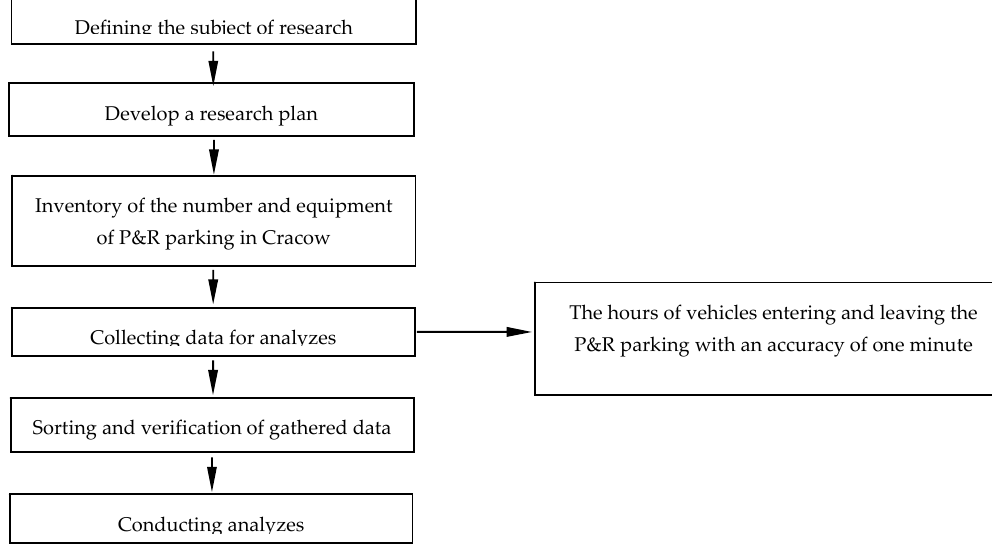
Figure 6. The research algorithm for the analysis of the use of P&R parking in